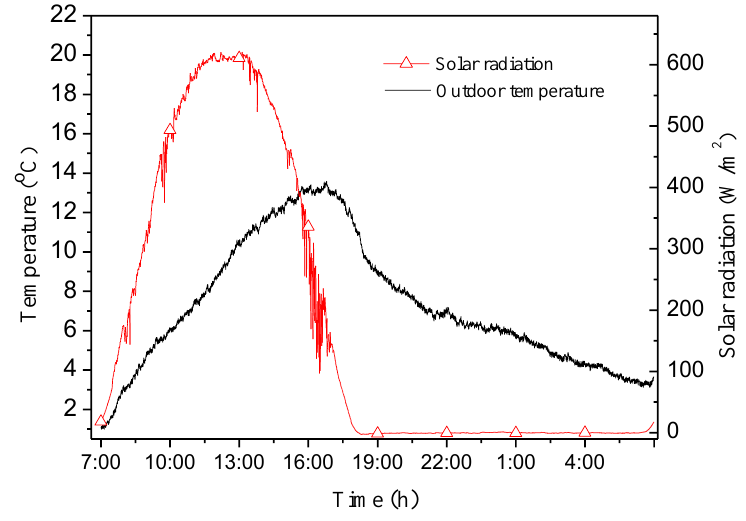
Figure 12. Ambient temperature and solar radiation on 3 March.